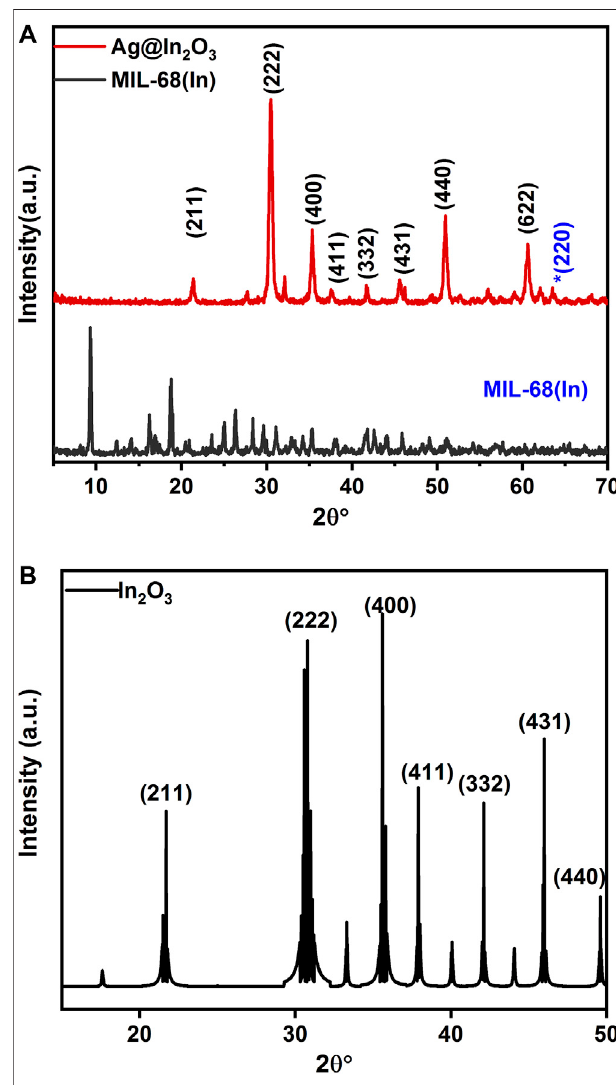
FIGURE2| XRDpatternof (A) isMIL-68(In)andAg@In 2 O 3 whereas (B) is 2 O 3